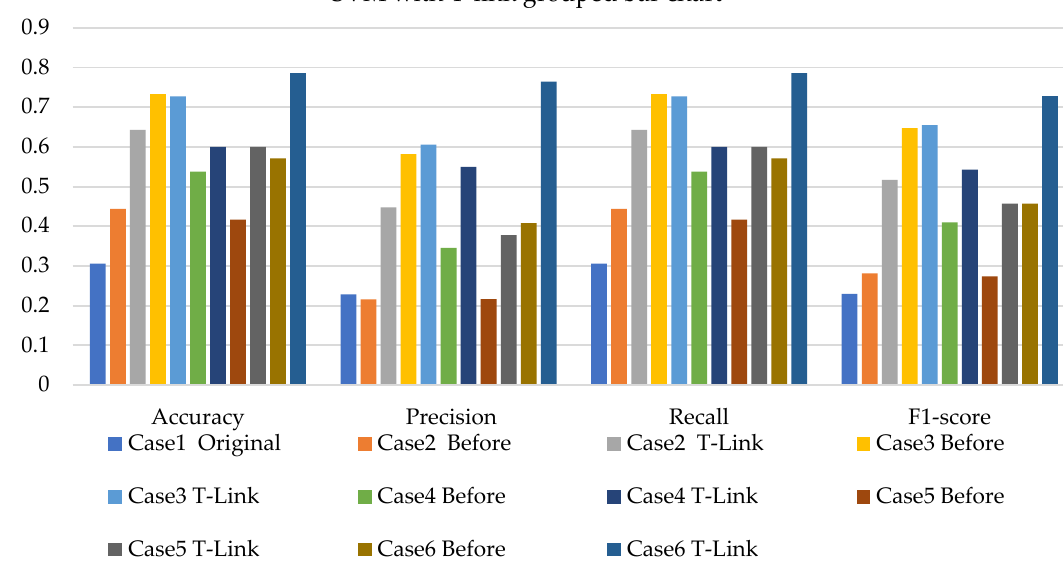
Figure 9. Simulation performance of SVM classification with T-link.